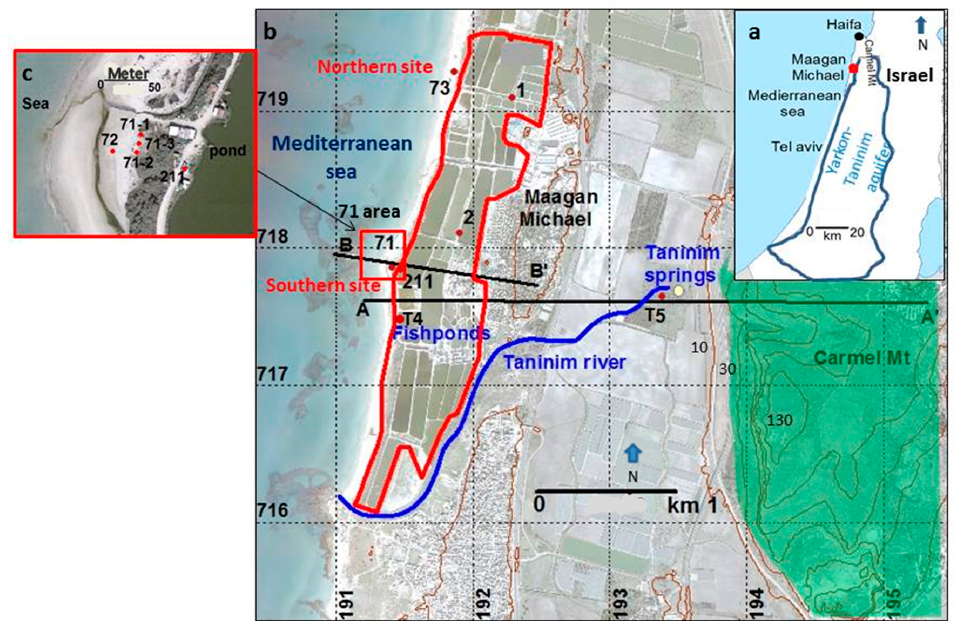
with a thickness of several meters, which is separated from the underlying Pleistocene calcareous